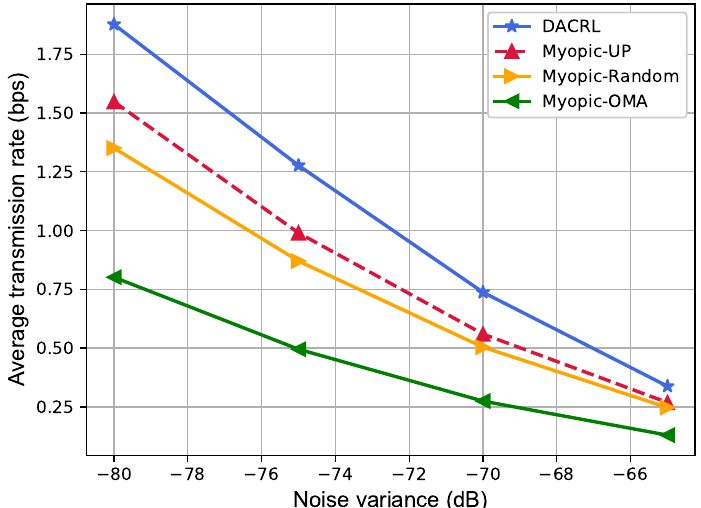
Figure 12. Average transmission rate according to noise